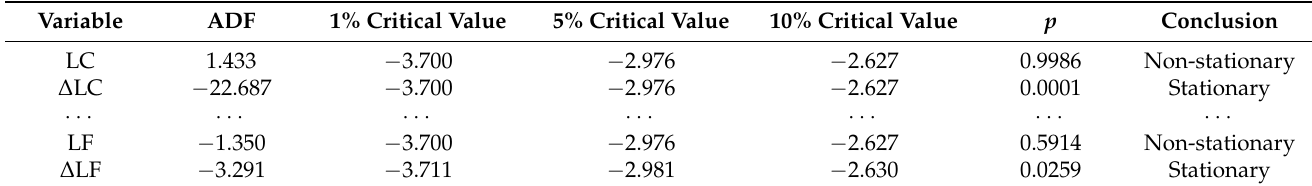
Table 3. Results of the ADF stationarity test for time series.